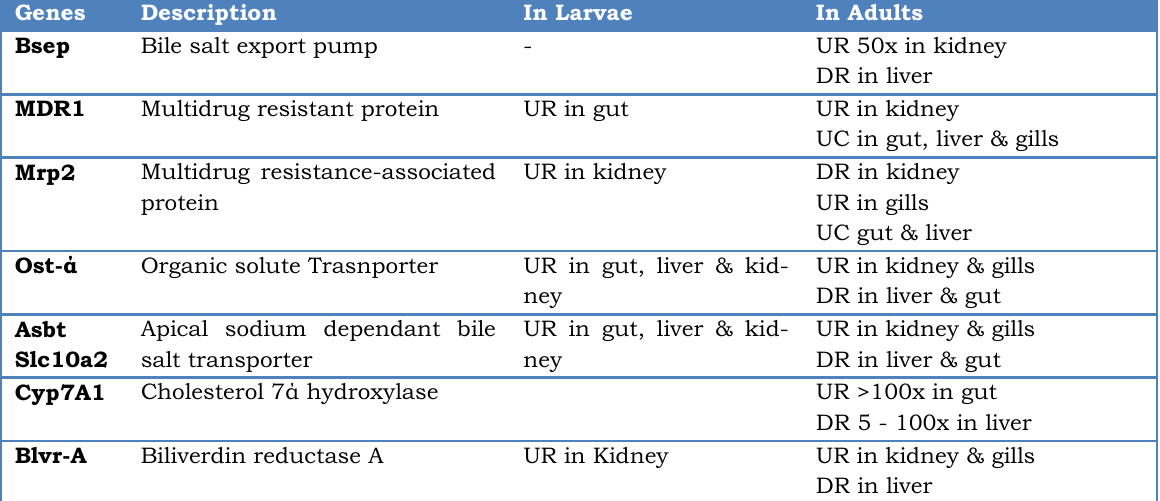
Table 2: mRNA Expression of various cell pumps involved in bile-salt excretion of lamprey